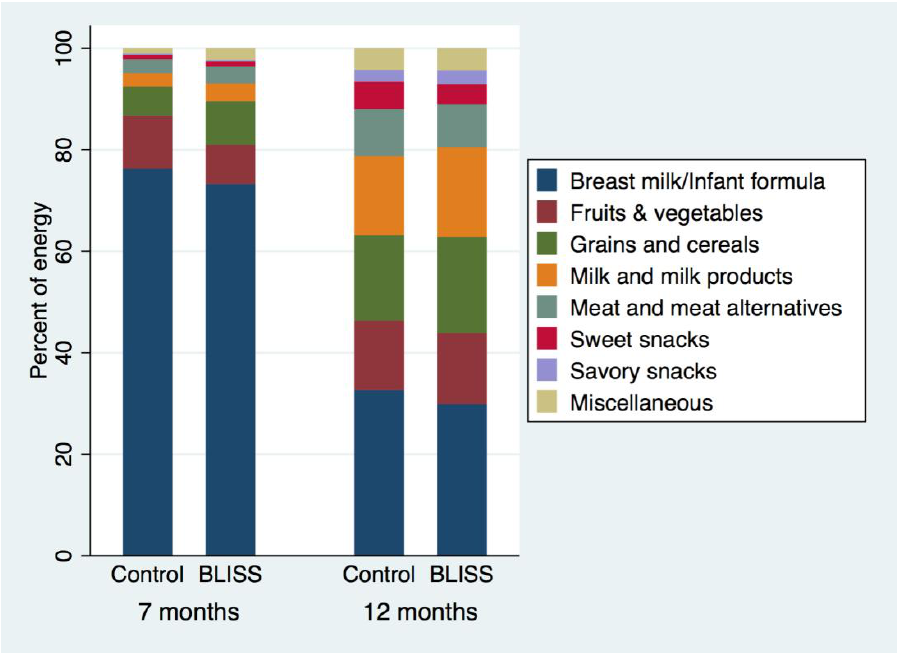
Figure 3. Mean proportion of energy from each food group at 7 and 12 months of age. See Figure 2 for definitions of the nine food groups that foods were assigned to